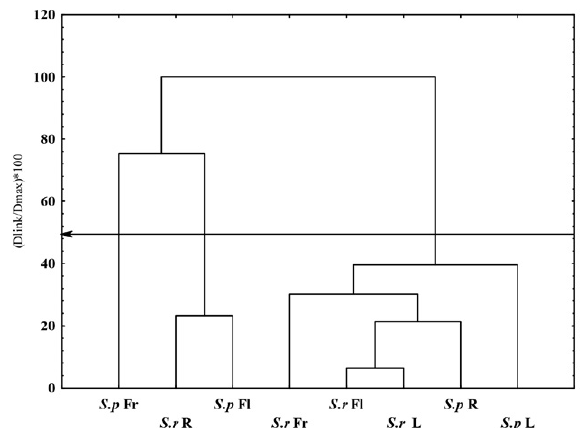
Figure 7. Dendrogram of heavy metals content (Cd, Cr, Ni, and Pb) in the leaf, flower, fruit, and root of plant species S. rigidum and S.